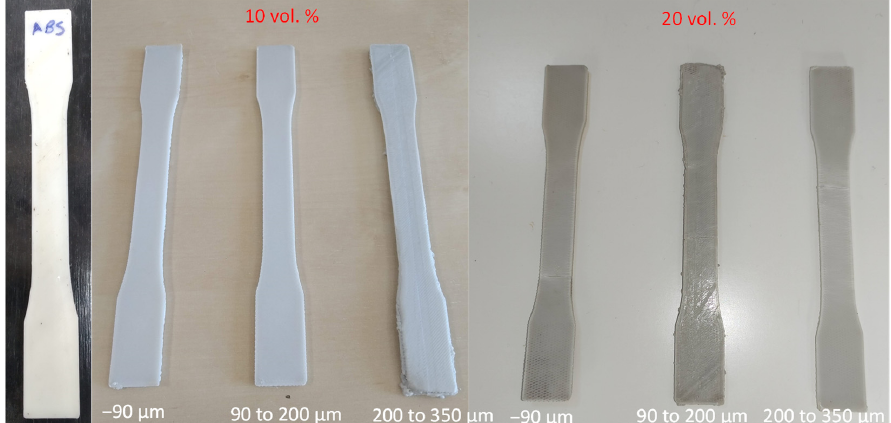
Figure 9. Dogbone samples printed using neat ABS and composite filament with different proportions of filler and different filler sizes.